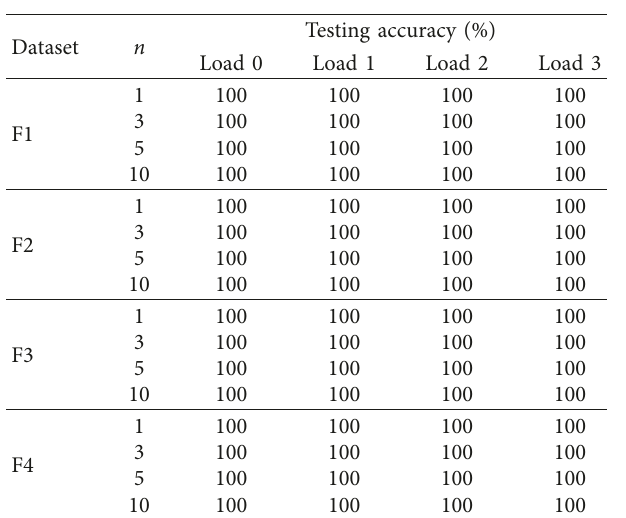
Table 7: The classification accuracy for outer-race fault severity detection.